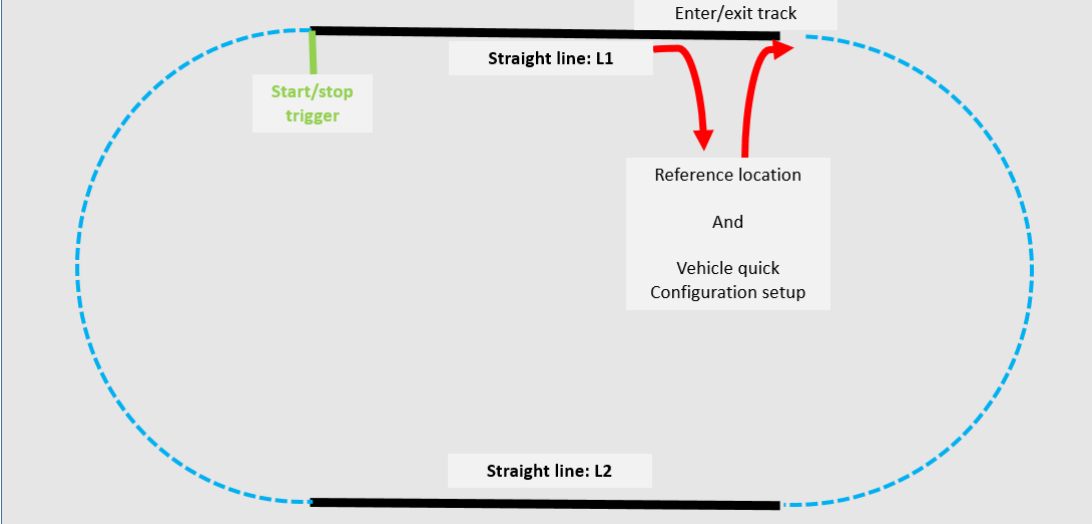
Figure 4. Test Track at Volvo Cars H¨allered Proving